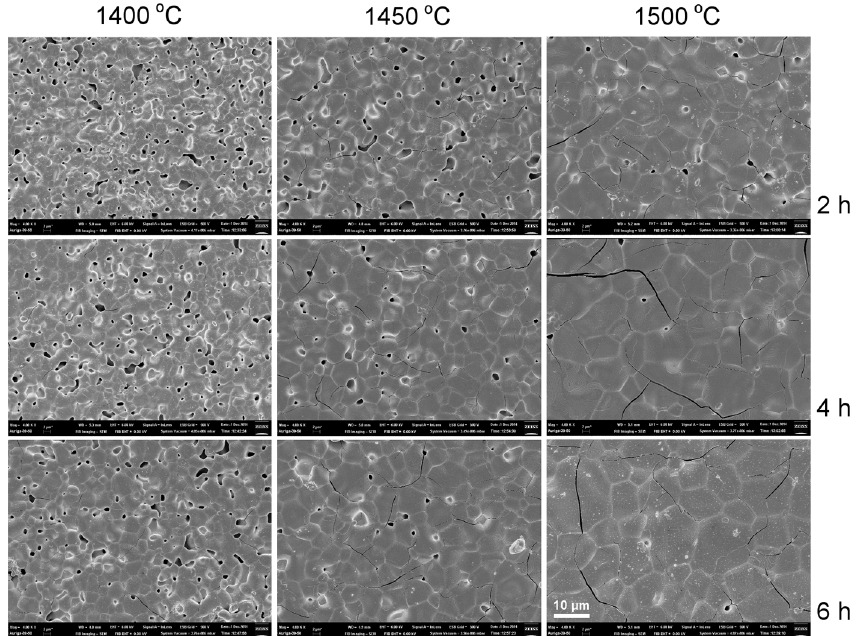
Figure 5. SEM photographs of the YCTM6 ceramics sintered at various temperatures and soak time. DC total conductivity of 1500 °C/6 h sintering YT, YCTM4, and YCTM6 ceramics are shown in Figure 6. Log σ is found from –8.19 Scm –1 at 350 °C to –4.94 Scm –1 at 700 °C for YT. Gill et